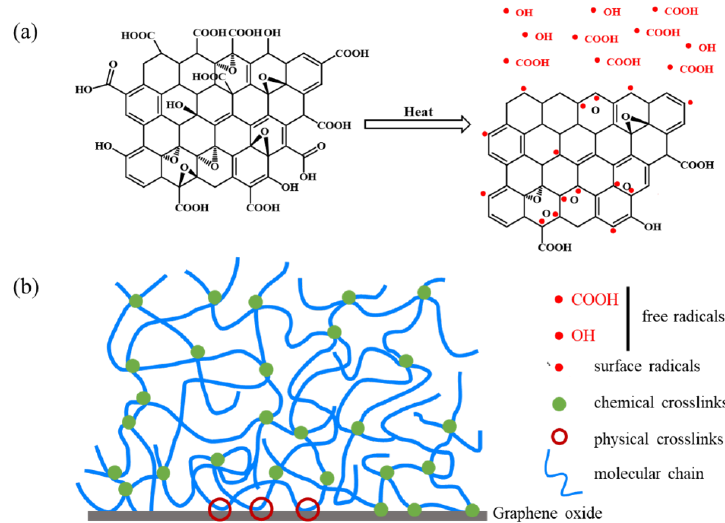
Figure 5. The swelling phenomenon of SPA composites in concentrated sulfuric acid: ( a ) SPA-1.0 wt% GO, ( b ) SPA-2.0 wt% GO.